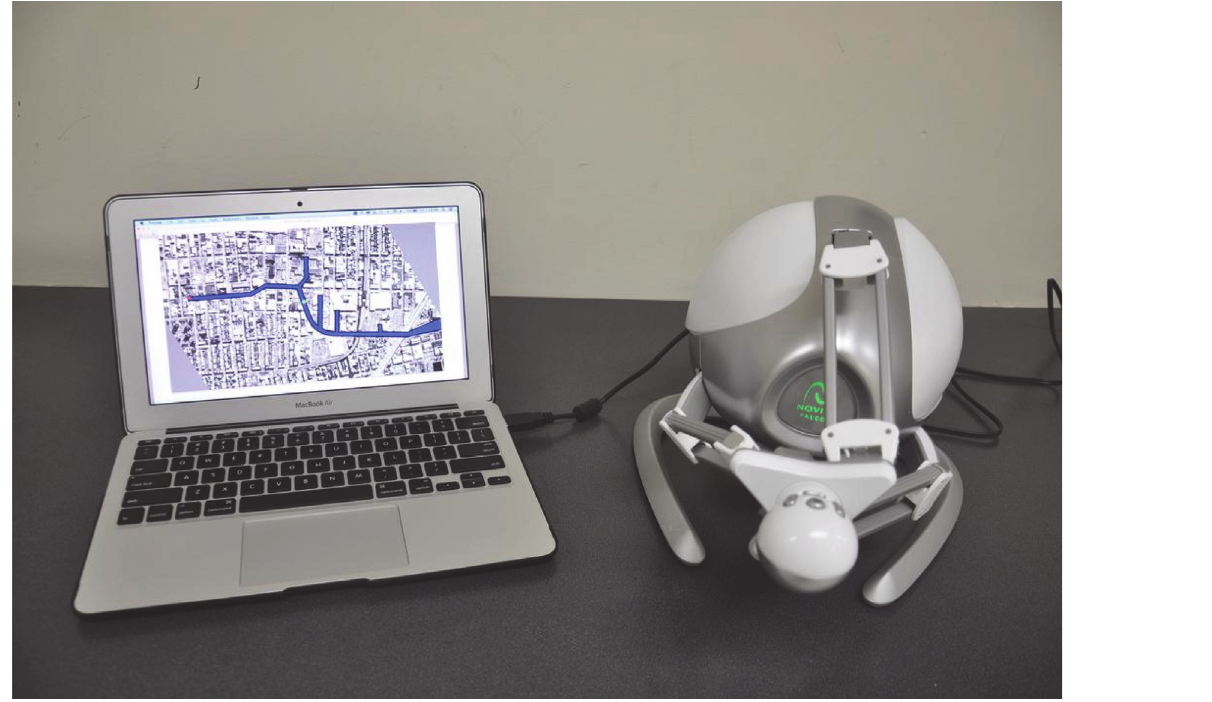
Fig 1. The experimental setup, consisting of a laptop computer and a Novint Falcon haptic